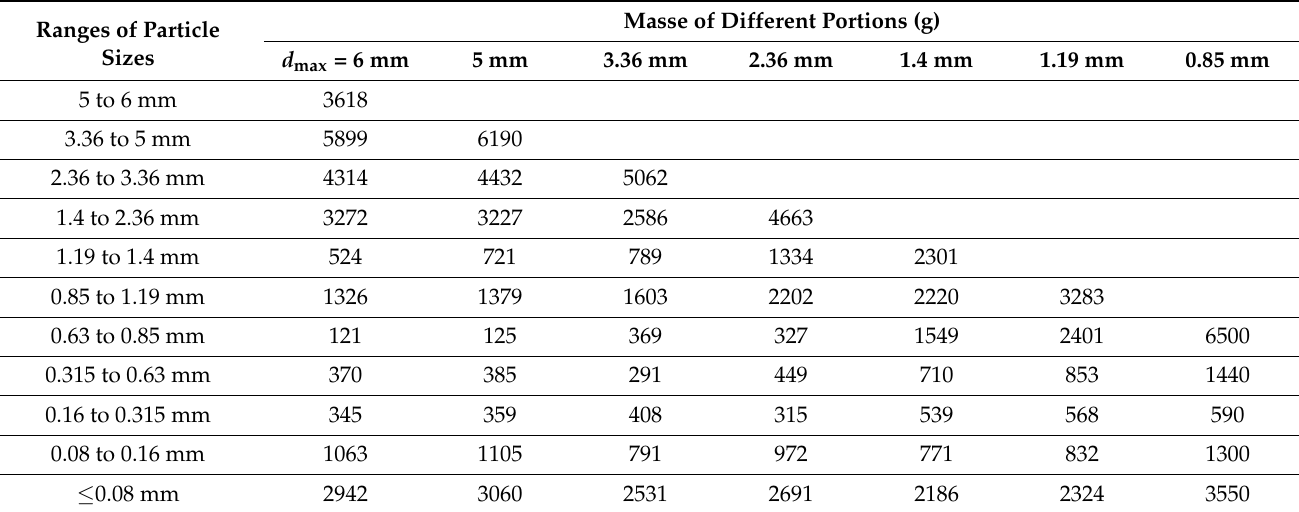
Table 9. Portions of waste rocks used to make the different mixtures.